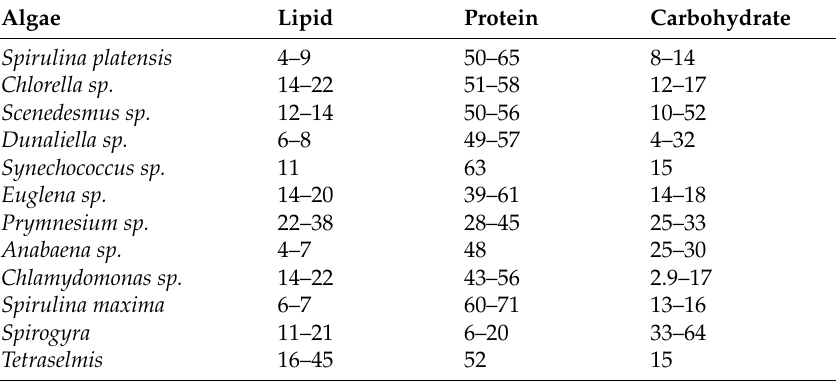
Table 3. Lipid, protein and carbohydrate composition of various microalgae % dw [146]. Algae Lipid Protein